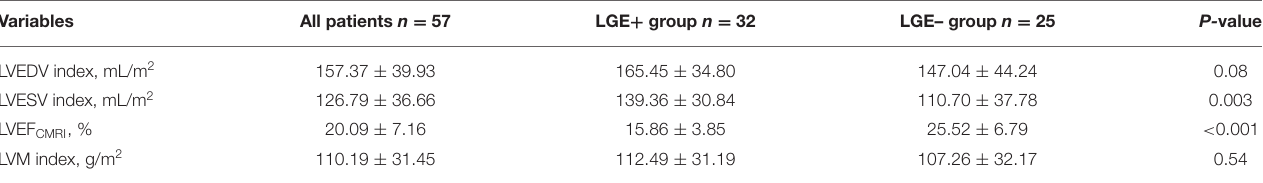
TABLE 3 | Cardiac magnetic resonance imaging parameters for the overall population and according to presence of LGE.